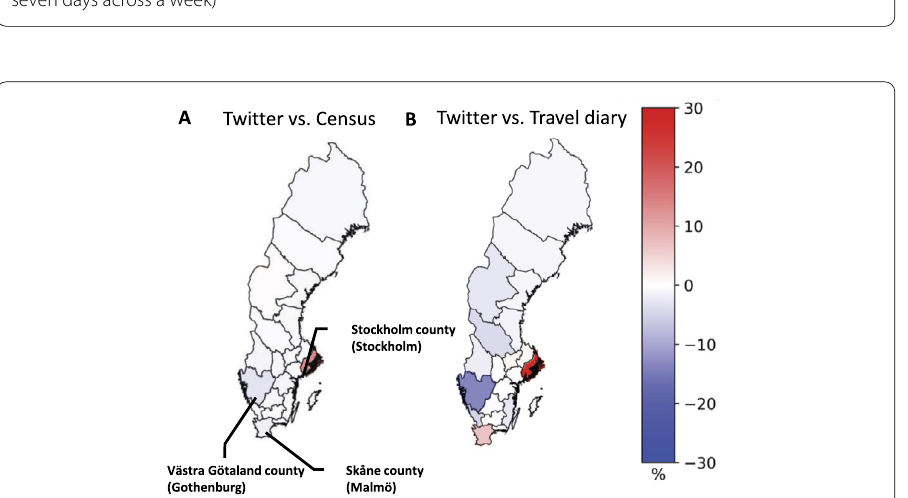
Figure 3 County-level geographical representativeness of estimated home locations from Twitter data: percentage value difference. ( A ) Twitter users vs. residents (Twitter minus Census population) [50]. ( B ) Twitter users vs. Swedish travel survey participants (Twitter minus